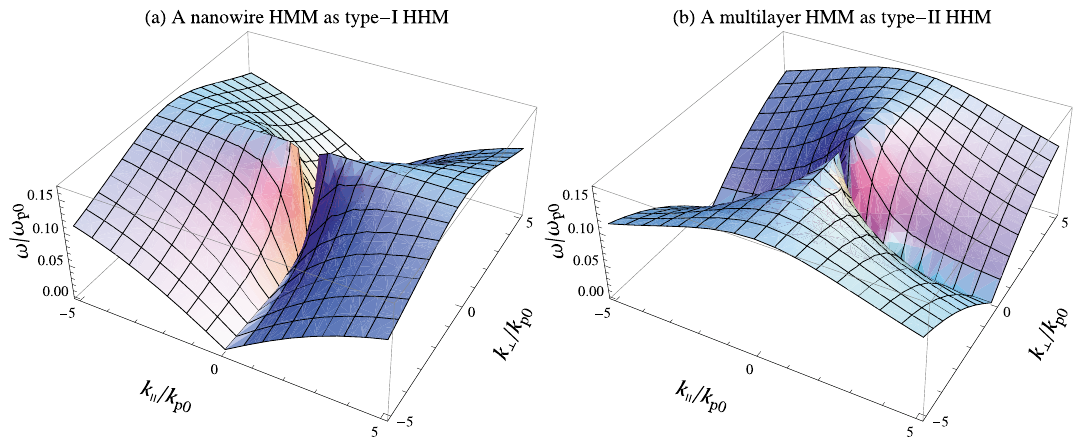
1 , and γ 0.01 ω p0 . The vertical dashed line = ∞ =